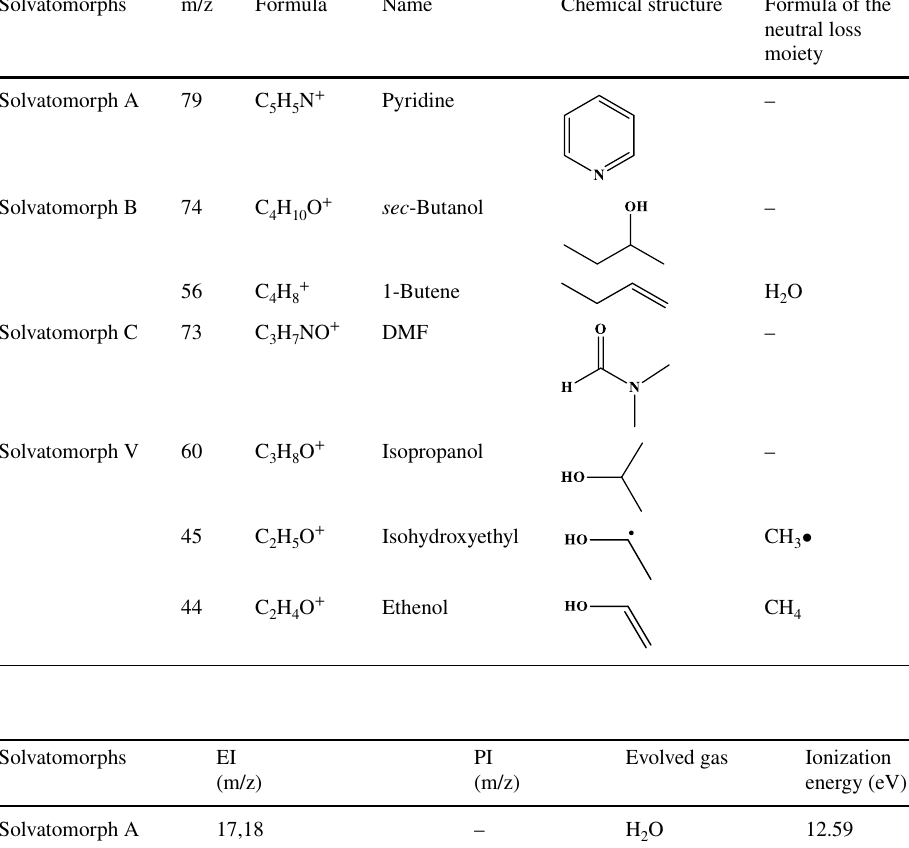
the chemical structure of the evolved gases of four solvatomorphs of BE at PI method